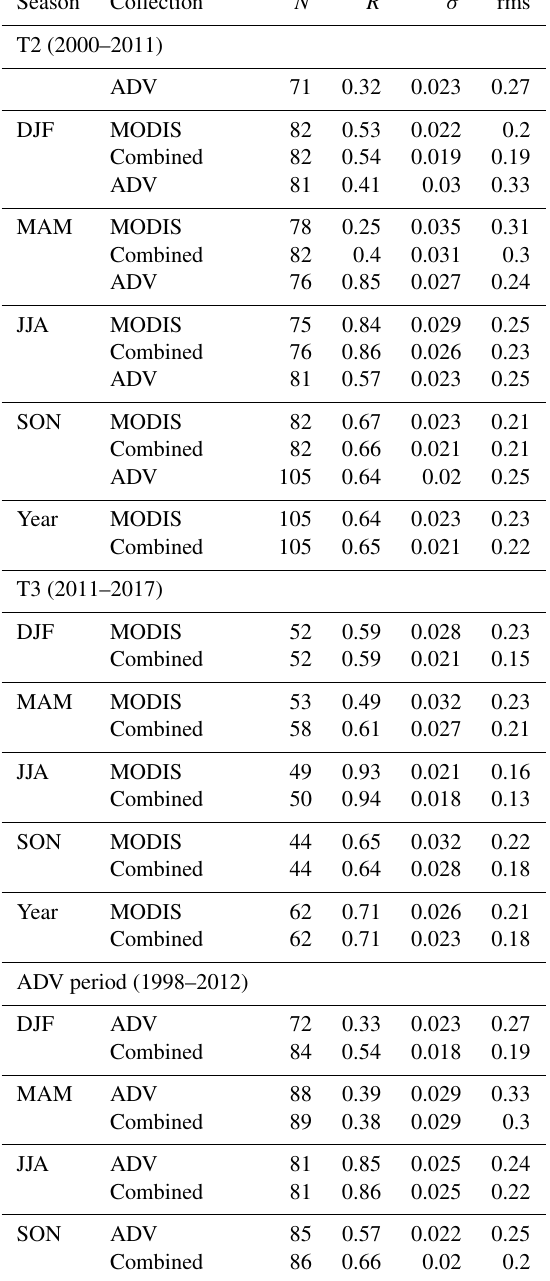
Table A1. Comparison of the seasonal and annual ADV, MODIS and combined AOD with AERONET AOD for different periods: T2 (2000–2011, ADV and MODIS overlap period), T3 (2011–2017, MODIS), ADV period (1998–2012), MODIS/Terra whole period (2000–2017); number of points ( N ), correlation coefficient ( R ), standard deviation ( σ ) and root mean square error